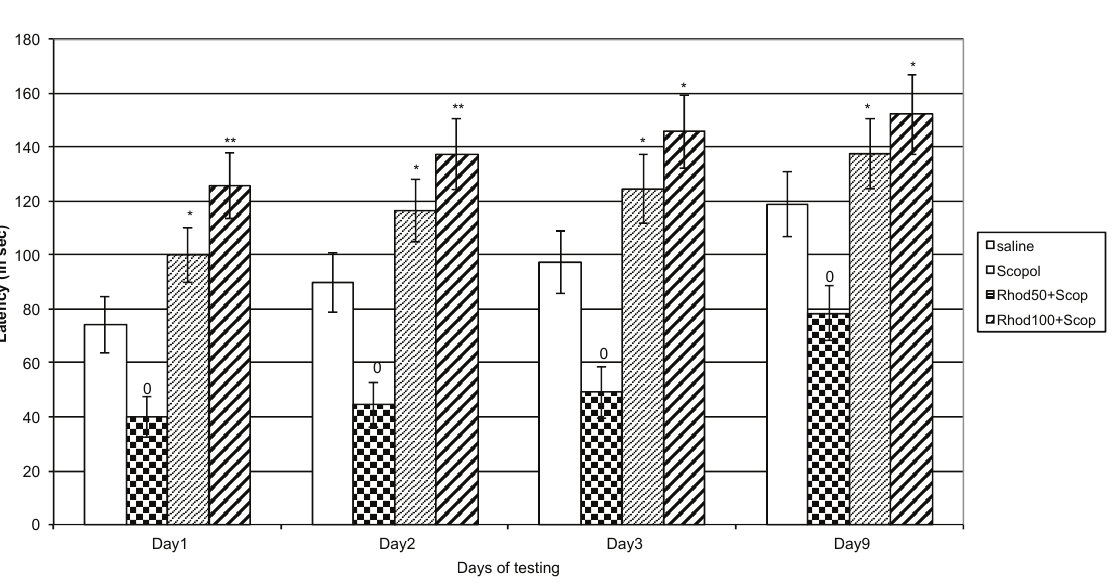
Figure 4. Effects of Rhodiola rosea extract on step-through test in rats with scopolamine-impaired memory. On the Abscissa: 2 days learning session, short and long memory retrieval. Ordinate: the latency of reaction in seconds. o P<0.05 compared with the fi rst day control; * P<0.05 compared with the same day of scopolamine